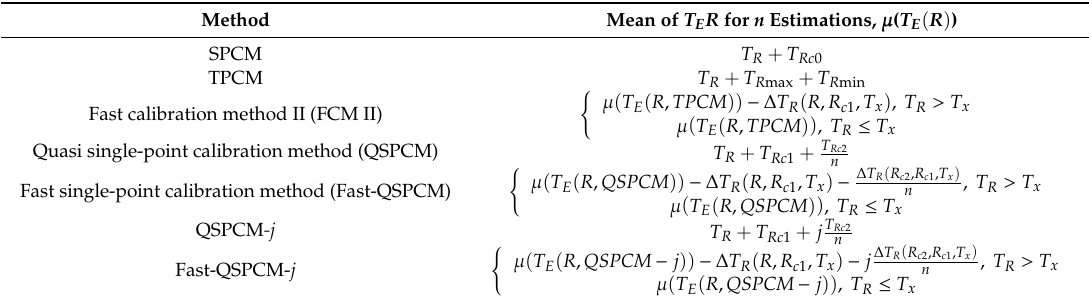
Table 1. Mean time for an estimation of R , if n estimations are made, both in traditional methods and in the methods presented in this